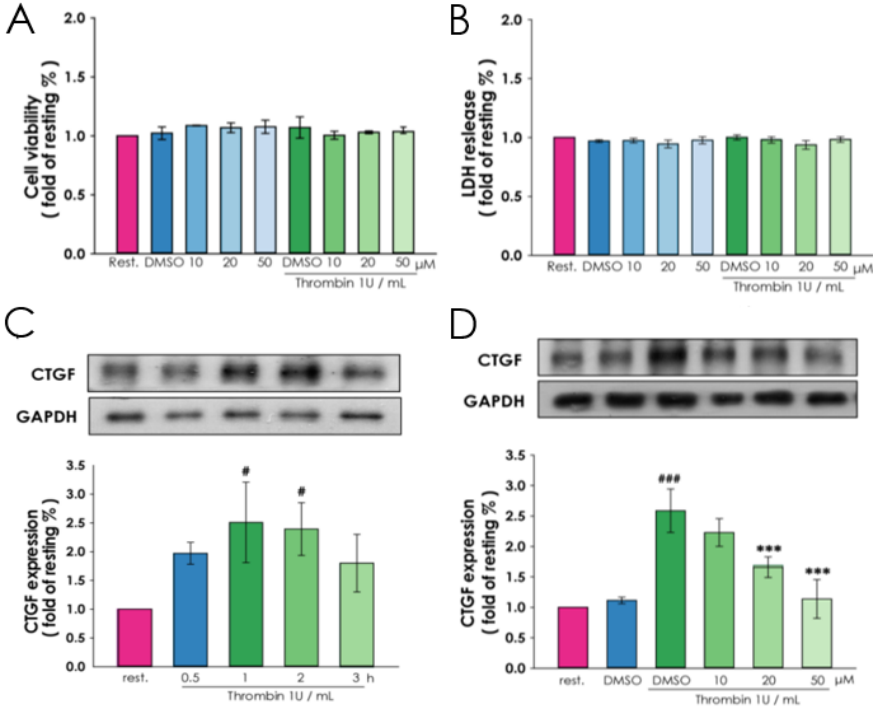
Figure 1. Influence of magnolol on thrombin-induced CTGF expression. A10 cells were incubated with magnolol (10, 20 or 50 µ M) or vehicle (0.05% DMSO) for 90 min and then treated with or without thrombin (1 U / mL) for 24 h. The cell viability and cytotoxicity were determined by ( A ) CCK-8 assay and ( B ) lactate dehydrogenase (LDH) test, respectively. ( C ) After serum-starved for 6 h, A10 cells were treated with thrombin (1 U / mL) for the indicated times (0.5–3 h), and the protein lysates were collected and subjected to Western blotting for evaluating the time course of CTGF protein expression. ( D ) To assess the influence of magnolol on the thrombin treated cell, the 6-h serum-starved A10 cells were incubated with magnolol (10–50 µ M) or vehicle (0.05% DMSO) for 90 min and followed by thrombin (1 U / mL) treatment for 2 h. Data ( A and B ) were presented as the means ± SD (n = 3). # p < 0.05 and ### p < 0.0001, compared with the ( C ) resting group and ( D ) DMSO alone group; *** p < 0.001, compared with the ( D ) DMSO alone group. The profiles are all representative examples of three similar